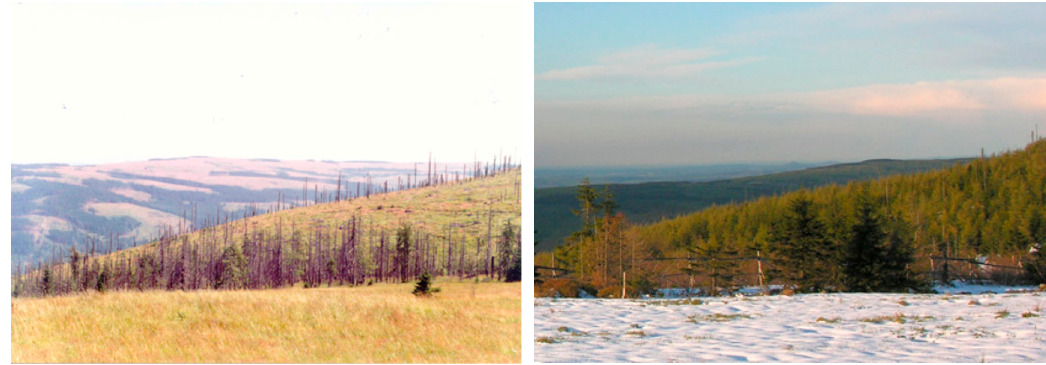
Figure 4. Forest stands in the Izerskie Mountains: Decline (1992) and recovery (2005). Photo by W. Grodzki.